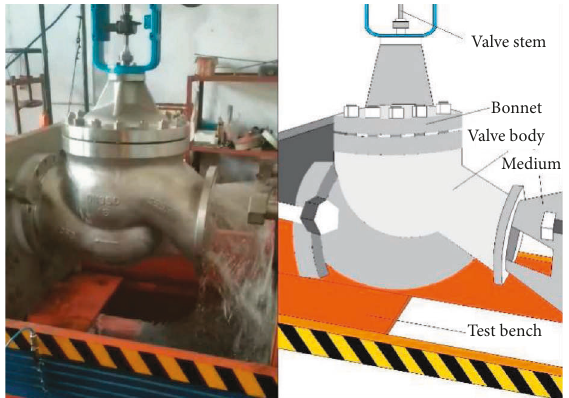
Figure 48: Noise-reducing two-stage cage control valve pressure resistance and sealing test.